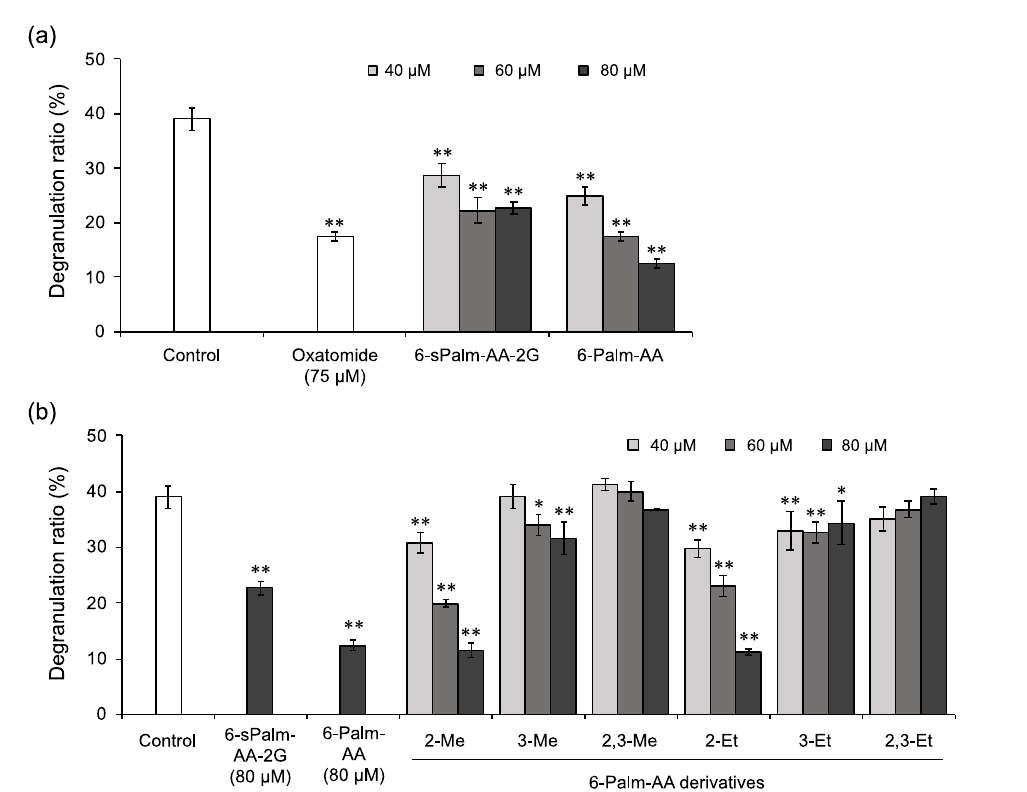
Figure 3. Inhibitory effects of 6-Palm-AA ( a ) and 6-Palm-AA derivatives ( b ) on antigen-induced degranulation. DNP-IgE-sensitized RBL-2H3 cells were incubated with the indicated samples and stimulated with DNP-HSA. All data represent the means ± SD of three independent cultures. * p < 0.05 and ** p < 0.01 (Dunnett’s test) as compared with the control.